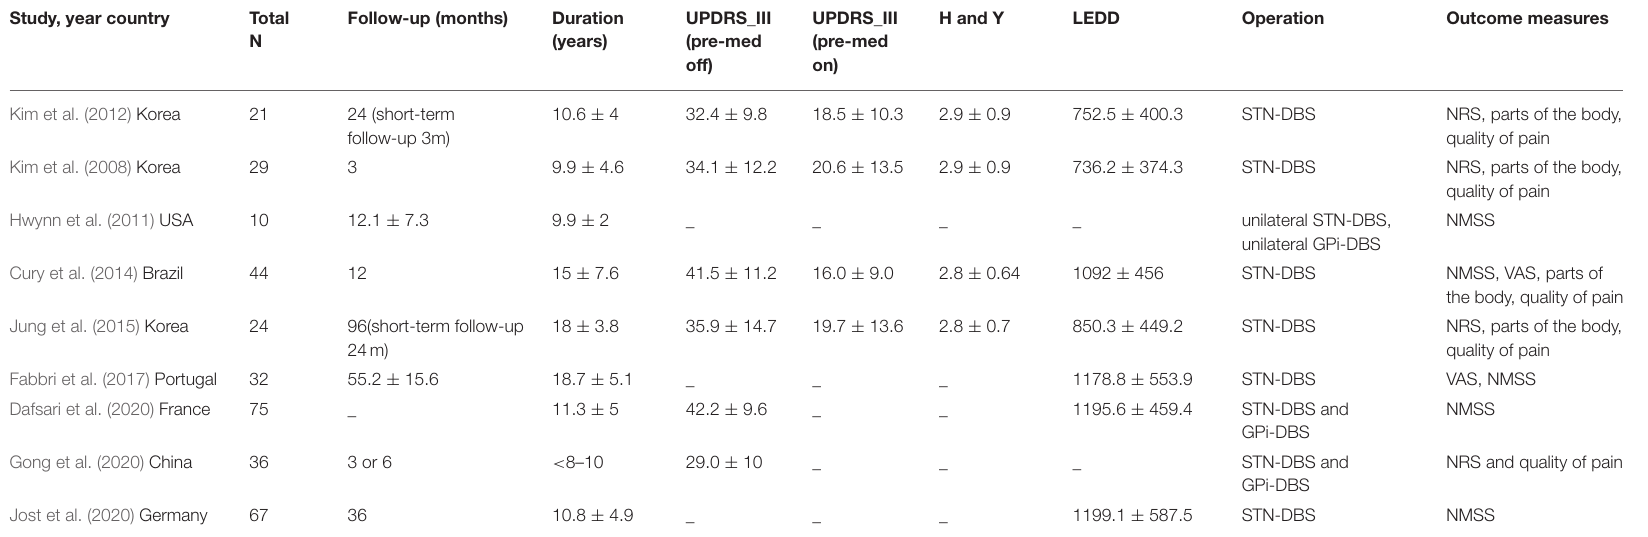
UPDRS, The Unified Parkinson’s Disease Rating Scale; LEED, levodopa-equivalent daily dose; NRS, numerical rating scale; VAS, visual analog scale; NMSS, non-motor symptom